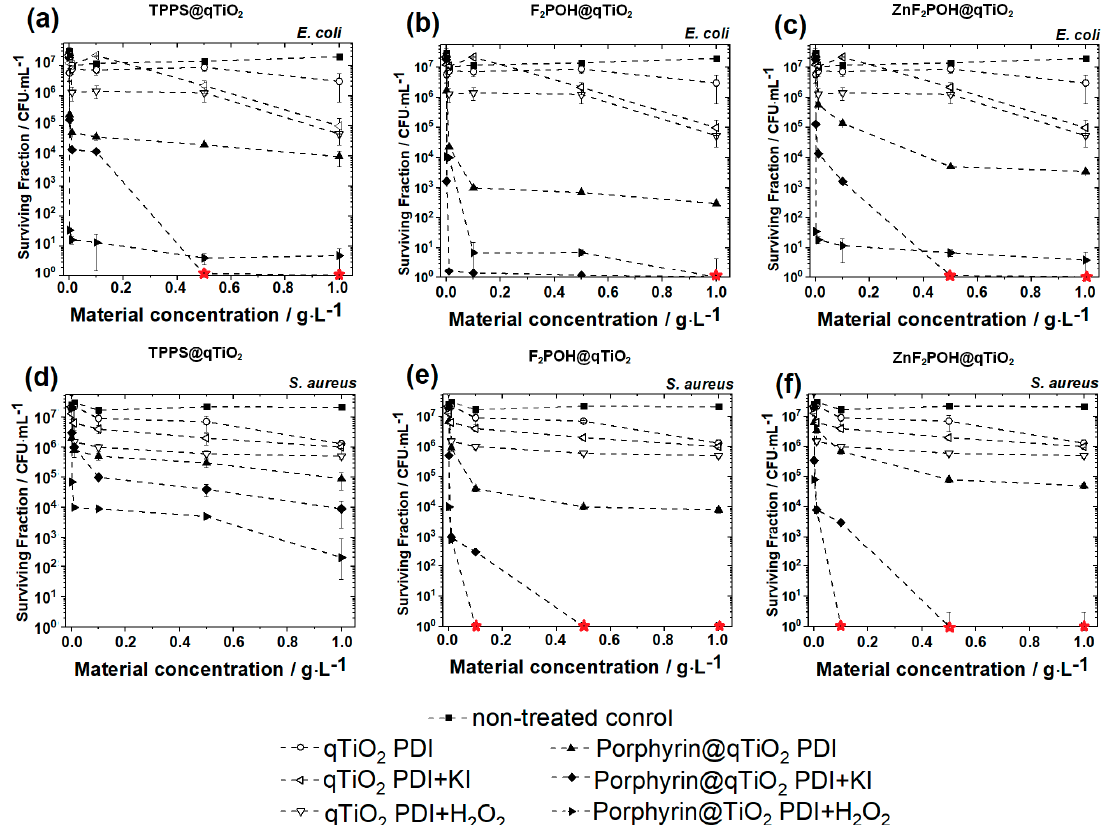
Figure 9. Photodynamic inactivation of Escherichia coli ( a–c ) and Staphylococcus aureus ( d–f ) mediated by qTiO 2 -based hybrid materials (TPPS@qTiO 2 , F 2 POH@qTiO 2 , and ZnF 2 POH@qTiO 2 ) and with addition of KI (100 mM) or H 2 O 2 (100 mM) after 2 h incubation and irradiated with 420 ± 20 nm LED light. Red symbols indicate the conditions required for complete bacteria eradication. Presented data are expressed as mean value ± SD.